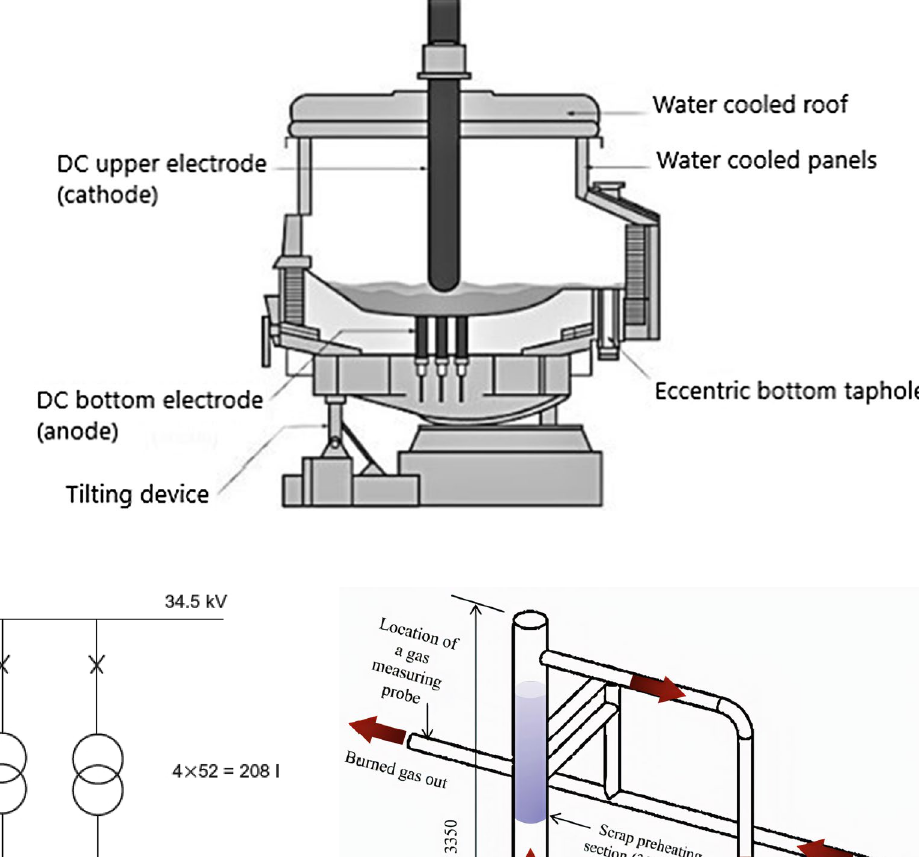
Fig. 9 DC EAF with one elec- trode and bottom anode [6]